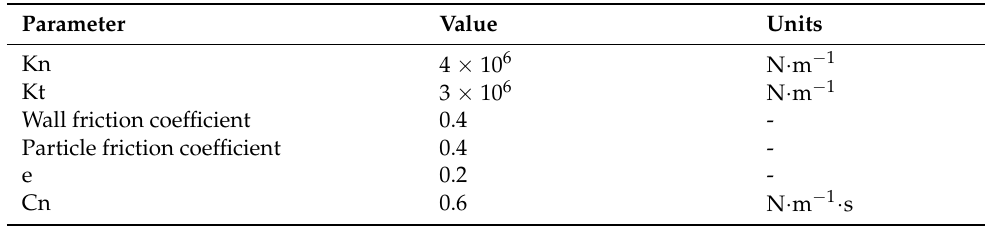
Figure 1. Design of the impact crusher and the rendering of its simulated version. Table 1. Model parameters.